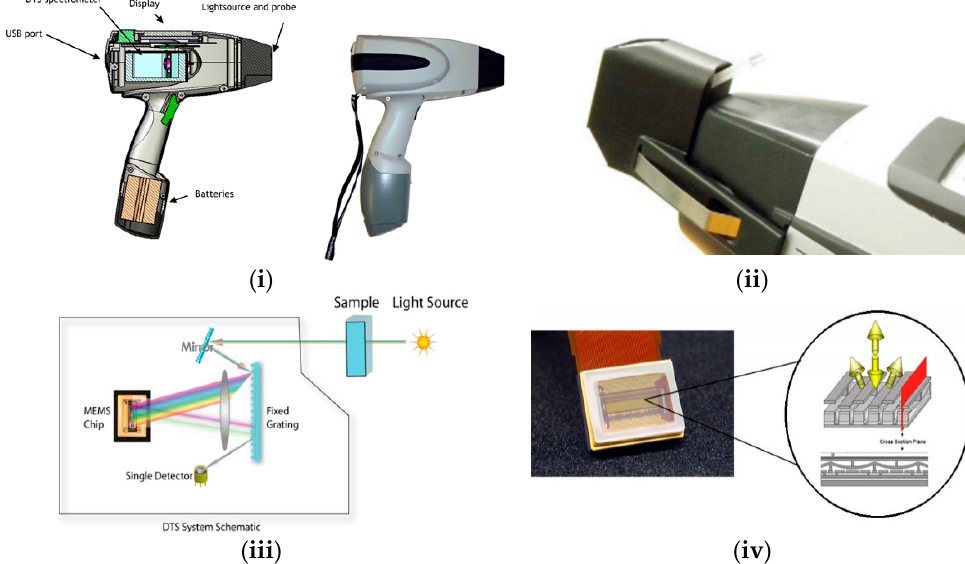
Figure 2. Handheld MEMS Phazir™ spectrometer. ( i ) The sideview of the Phazir™ spectrometer; ( ii ) Microphazir™ with a liquid cuvette adaptor (images are originally from [46]); ( iii ) Schematic of a post-dispersive instrumental design incorporating MEMS technology (image is originally from [46]); ( iv ) MEMS diffraction grating, multi-layer MEMS in reflective state (image is originally from